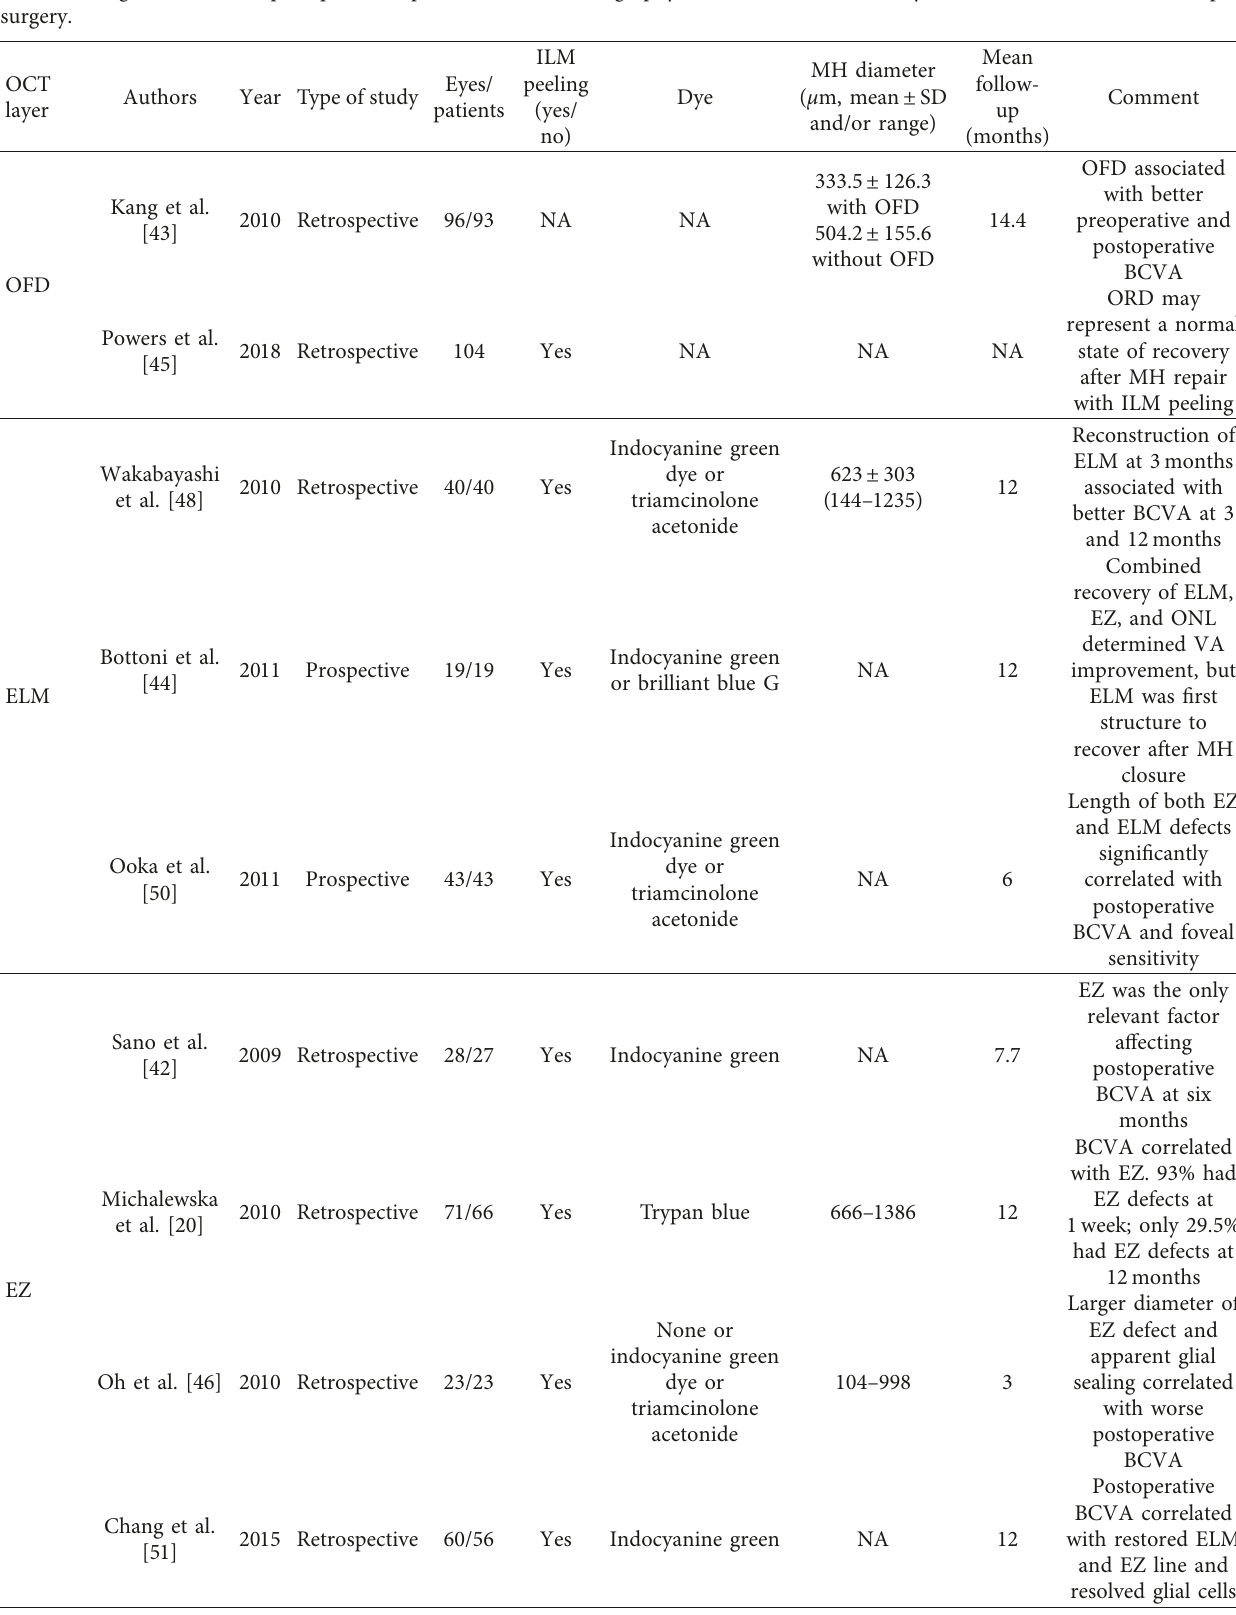
Table 2: Prognostic value of postoperative optical coherence tomography (OCT) external retinal layers after macular hole (MH) repair